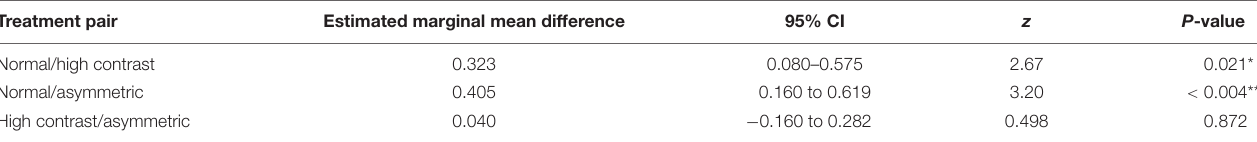
TABLE 2 | Pairwise comparisons of the slopes of the learning curves observed by a group of naïve bees for each treatment level during the training phase. Treatment